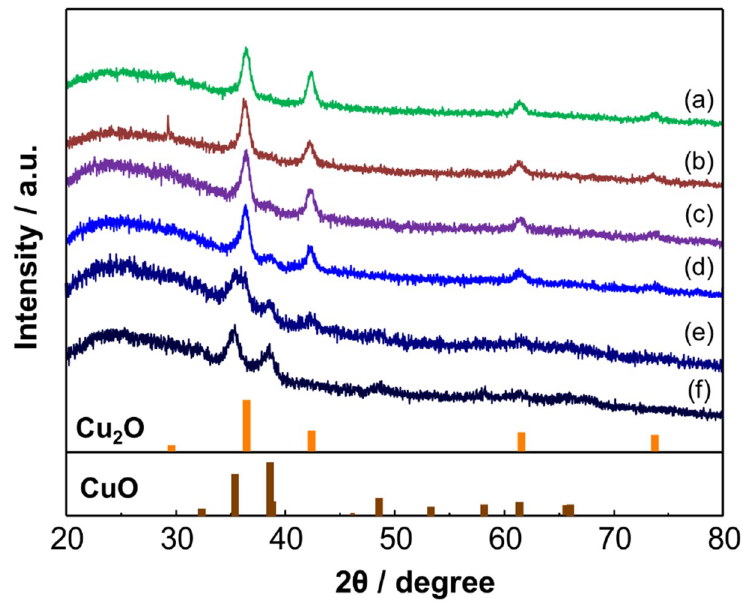
Figure 6. XRD patterns of Cu 2 O NCs heated at ( a ) 50, ( b ) 100, ( c ) 150, ( d ) 200, ( e ) 250, and ( f ) 300 °C for 30 min in air. Cu 2 O: JCPDS file no. 05-0667, CuO: JCPDS file no. 45-0937.